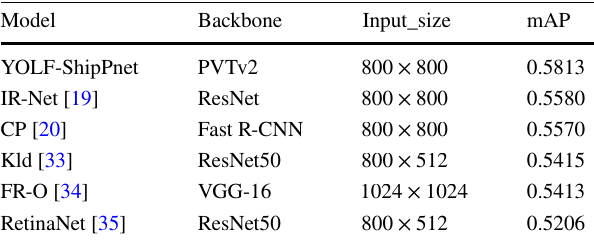
Table 9 Performance of YOLF-ShipPnet and other networks on HRSC2016